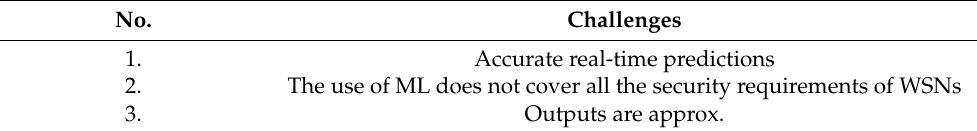
Table 3. ML challenges in WSN